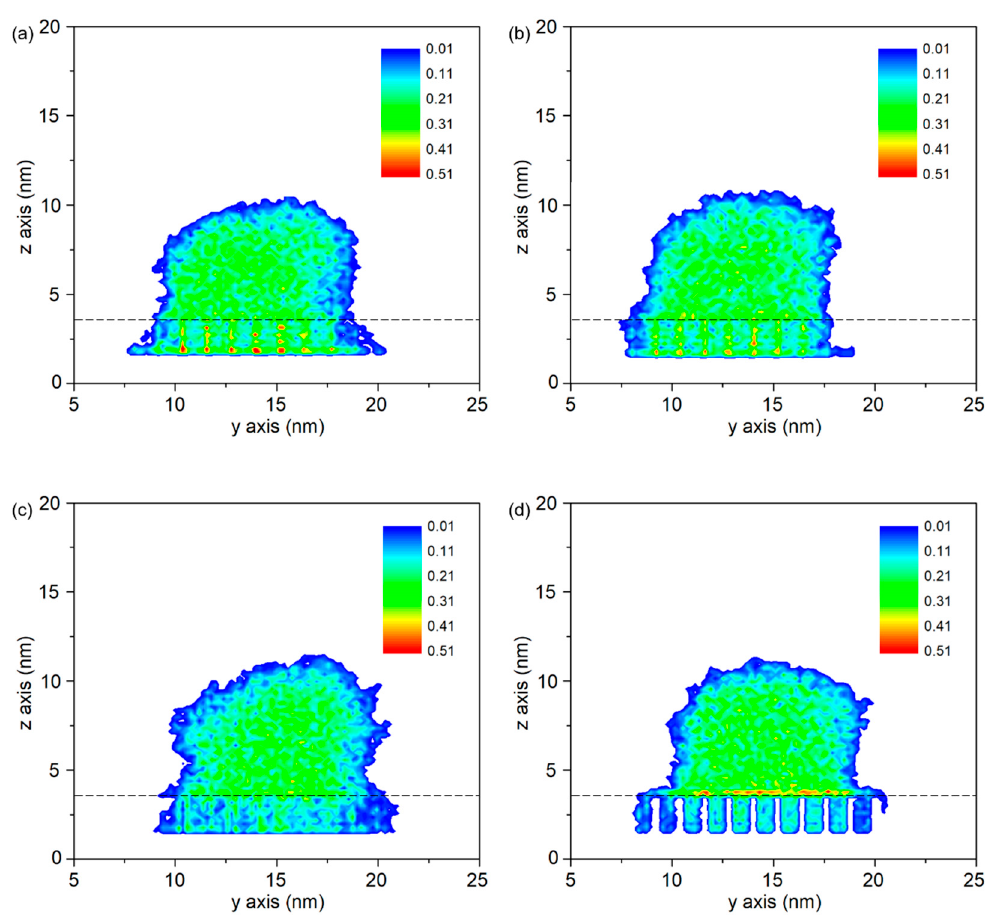
Figure 6. Density distributions of the PP droplets on Al substrate with different rough surfaces. ( a ) column arrays with side length of 0.40 nm (P1), ( b ) column arrays with side length of 0.64 nm (P2), ( c ) column arrays with side length of 0.81 nm (P3) and ( d ) column arrays with side length of 1.21 nm (P4).